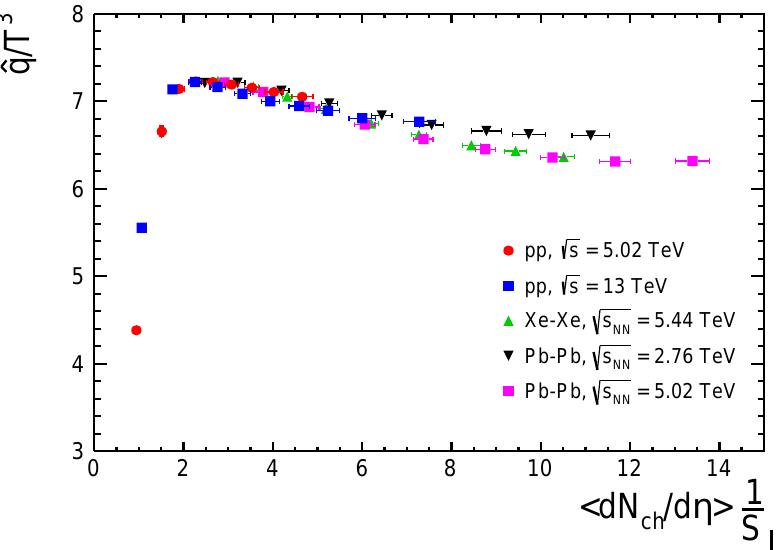
√ s = 5.02 and √ s NN = 2.76 and 5.02